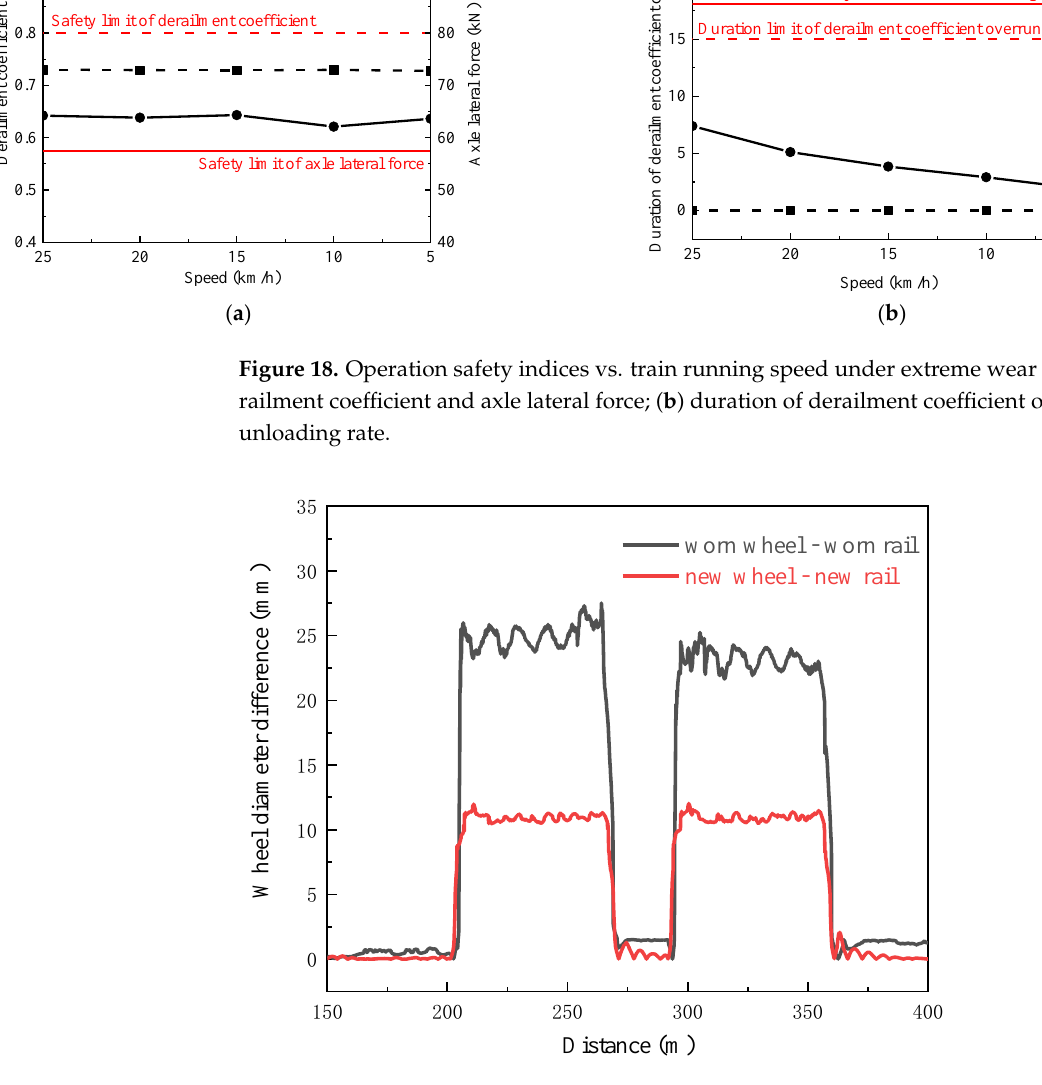
Figure 20. Duration of derailment coefficient overrun vs. train running speed. As shown in Figure 20, the derailment factor overrun time decreases with the de- crease in the speed in the range of 5 to 25 km/h. When the speed is below 15 km/h, the derailment factor overrun time is within the safety limit. Thus, under this condition, there will be no wheel climb derailment. The comparison of Figures 15b and 20 shows that the worn rail reduces the safety when the train passes through the yard line. 5. Conclusions The operational safety and speed limit of LIM trains running through an inbound- outbound line were studied through the established LIM subway train-track (including the secondary conductive plate) coupled dynamic six-group model. When the LIM train passes through the yard line at a speed below 25 km/h, for both new wheel matchings with the new rail and worn rail, the changes in the derailment coefficient and axle lateral force with the decrease in the speed were small, but both seriously exceeded the safety 25